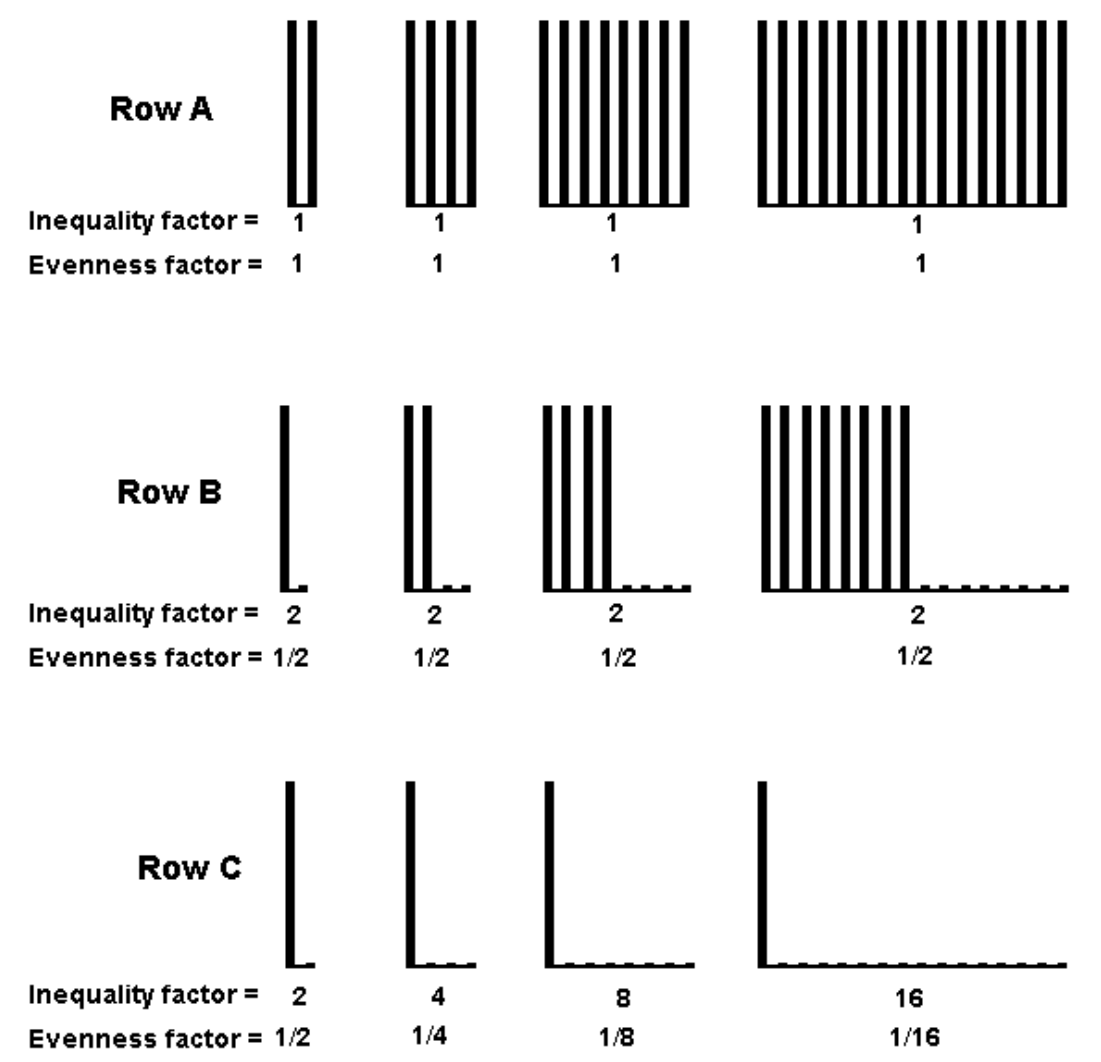
Figure 1. Inequality and evenness factors. In Row A, all communities are maximally even, so their inequality factors are all unity. Their evenness factors are also all unity. In Row B, communities all have an inequality factor of 2 and an evenness factor of ½. In Row C, the communities show maximal inequality; their inequality factors equal the number of species. Evenness factors are their